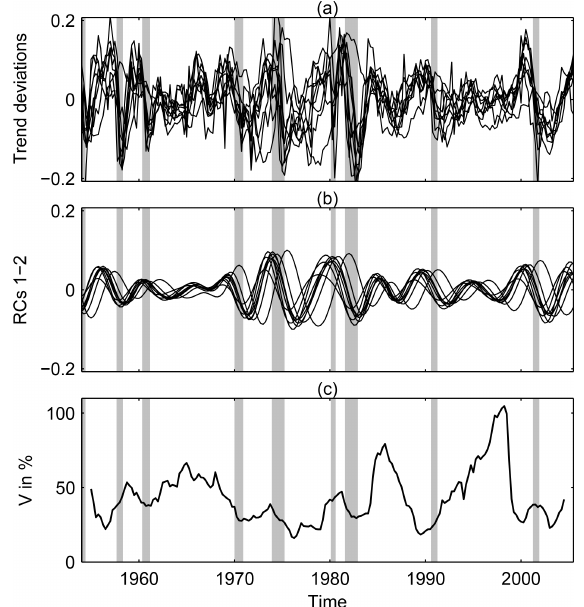
Figure 8. USA business cycles and the implied fluctuation– dissipation result. Time series of nine USA macroeconomic in- dicators during 1954–2005. (a) Normalized trend residuals, (b) data-adaptive filtered business cycles, captured by the leading os- cillatory mode of the multichannel singular spectrum analysis (M-SSA) and (c) local variance V K (t) of the fluctuations. The shaded vertical bars indicate the National Bureau of Economic Research (NBER)-defined recessions (see https://www.nber.org/ cycles/cyclesmain.html, last access: 11 September 2020). Repro- duced from Groth et al. (2015a), with permission from AGU